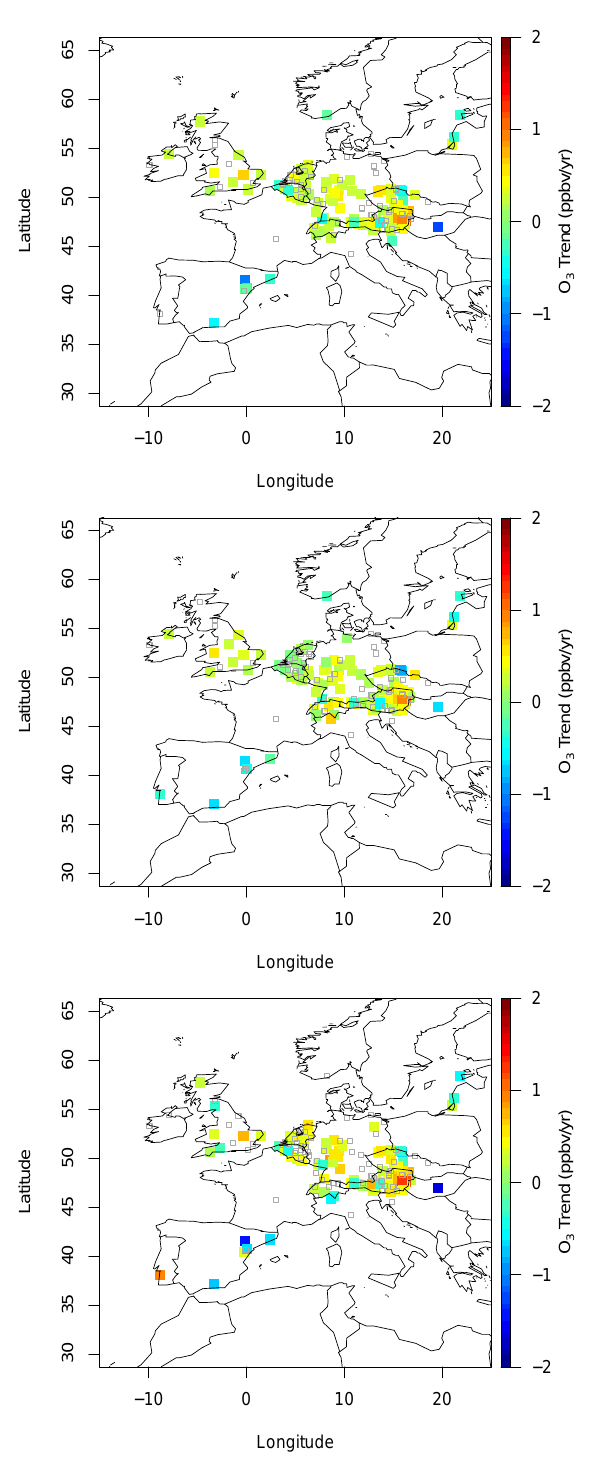
Fig. 5. Spatial distribution of statistically significant annual trends ( p < 0.1) in observed O 3 mean (top), 5th (middle) and 95th (bot- tom) percentiles. Open squares represent sites with no statistically significant trends.